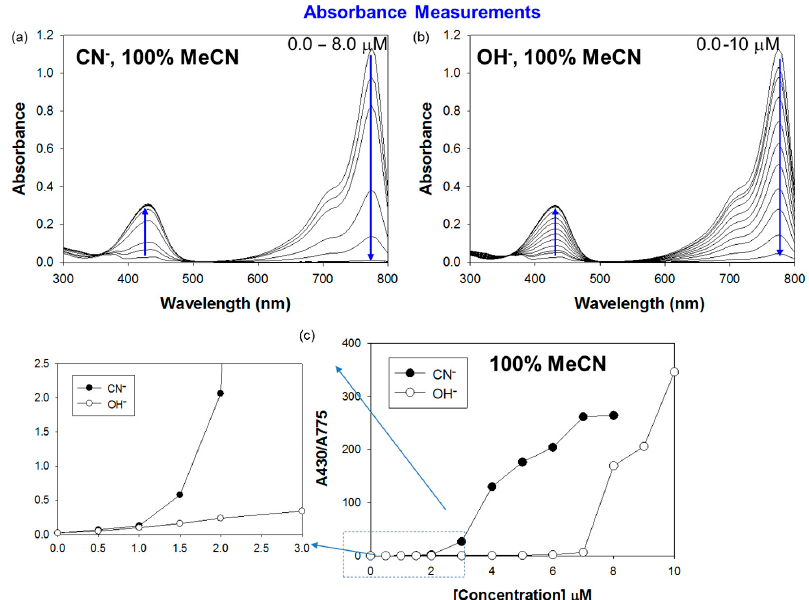
Figure 3. UV-vis absorption spectra of IR-786 in 100% MeCN (5 μ M) before and after the addition of ( a ) CN − (up to 8 μ M) and ( b ) OH − (up to 10 μ M) and ( c ) absorbance ratiometric values (absorbance value at 430 divided by absorbance value at 775 nm) obtained from (a). Arrows show the direction of increased amount of anions.